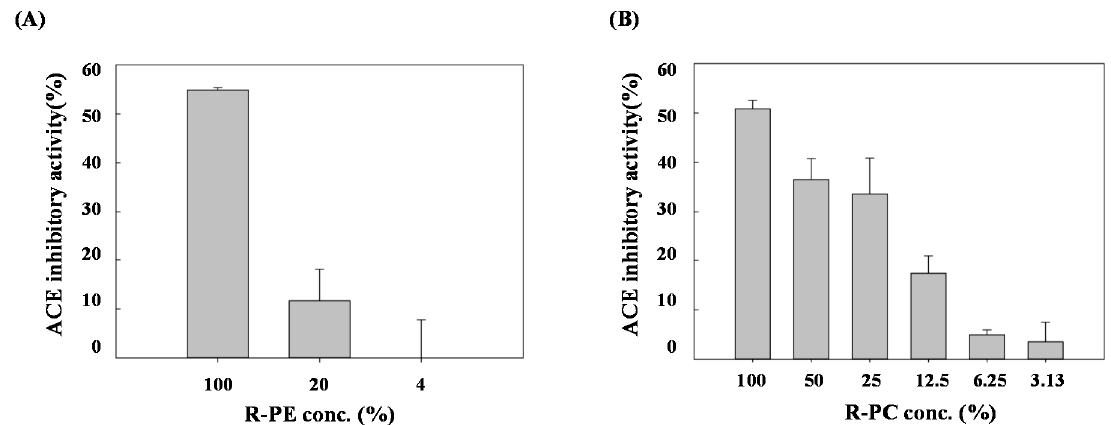
Figure 7. Angiotensin converting enzyme (ACE) inhibitory activity1 of ( A ) R-PE and ( B ) R-PC fractions. Deionized water was employed as the control group (without ACE inhibition).